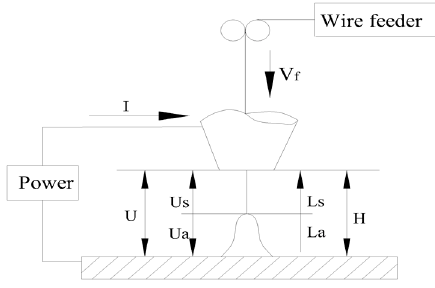
Figure 1 . Monitored voltage composition. Figure 1. Monitored voltage composition.